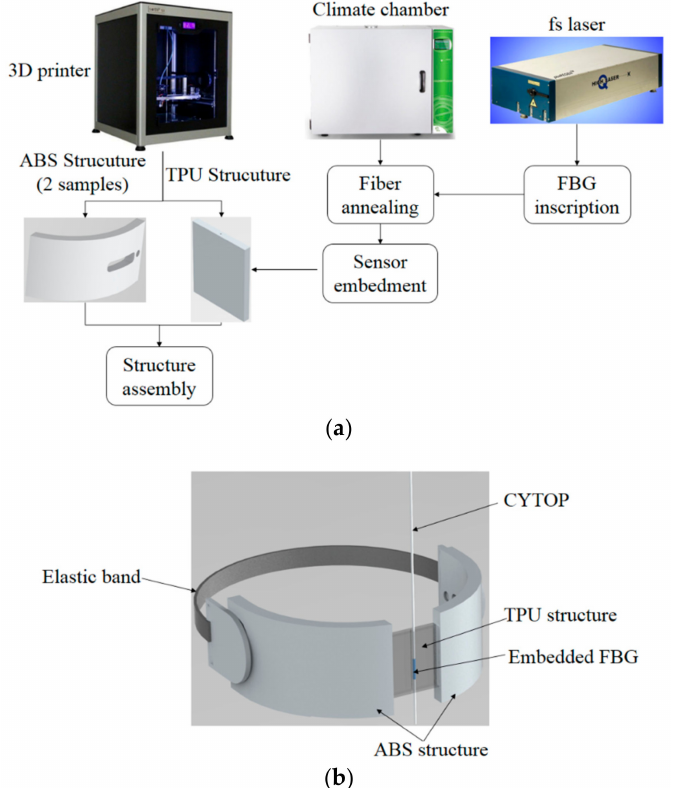
Figure 1. ( a ) Block diagram of the proposed method for the three-dimensional (3D)-printed, fiber Bragg grating (FBG)-embedded flexible support fabrication; ( b ) Schematic representation of the assembled flexible support. ABS = acrylonitrile butadiene styrene; TPU = thermoplastic polyurethane; fs = femtosecond; CYTOP = cyclic, transparent, optical